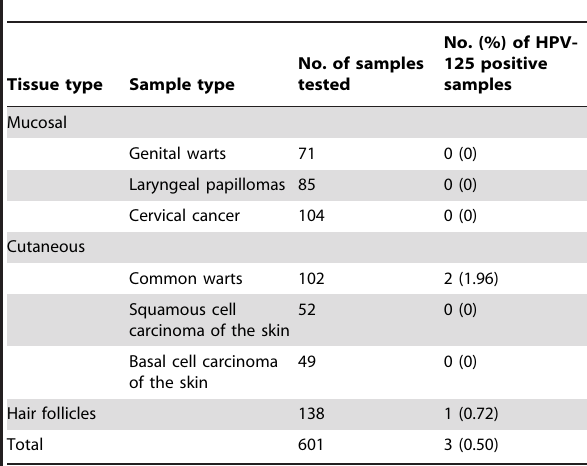
Table 2. Clinical samples tested for the presence of